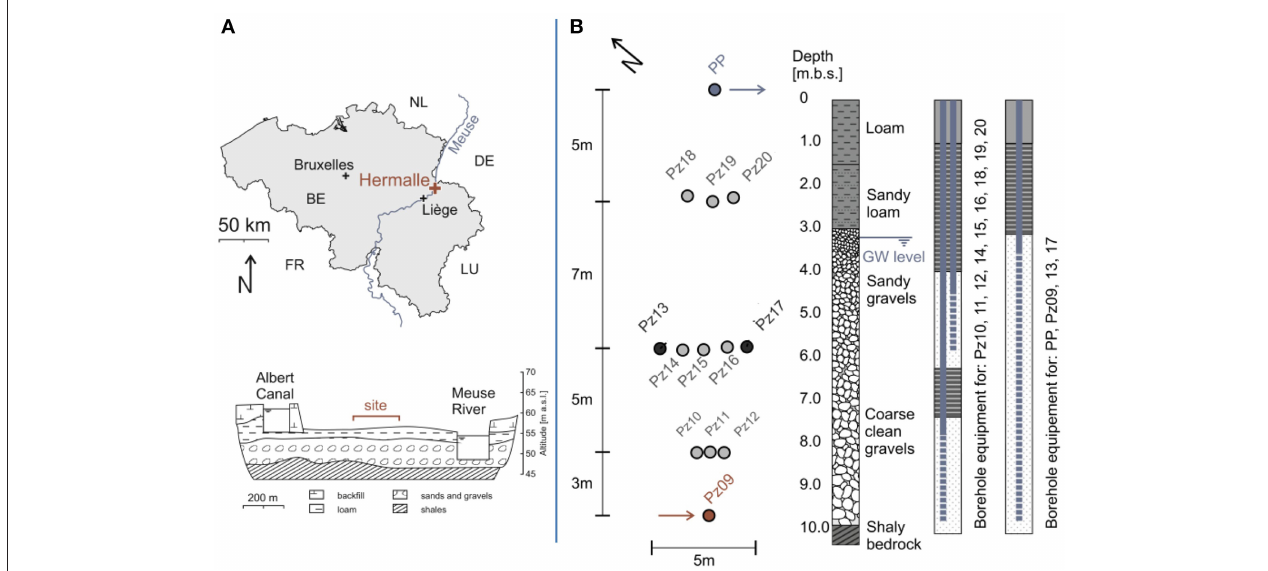
FIGURE 1 | (A) Overview of the field site location. (B) Borehole location showing the three panels between the injection well (Pz9) and the pumping well (PP), a typical log, and borehole equipment [modified figure according to Wildemeersch et al. (2014)].